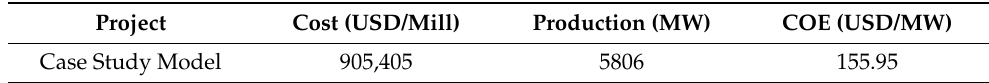
Table 5. A summary for cost outputs for the PS-CSM.